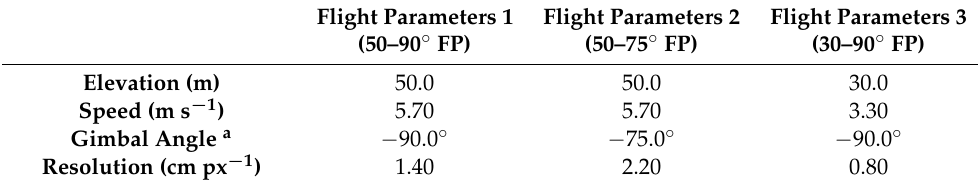
Table 1. The flight parameters for the three types of missions.